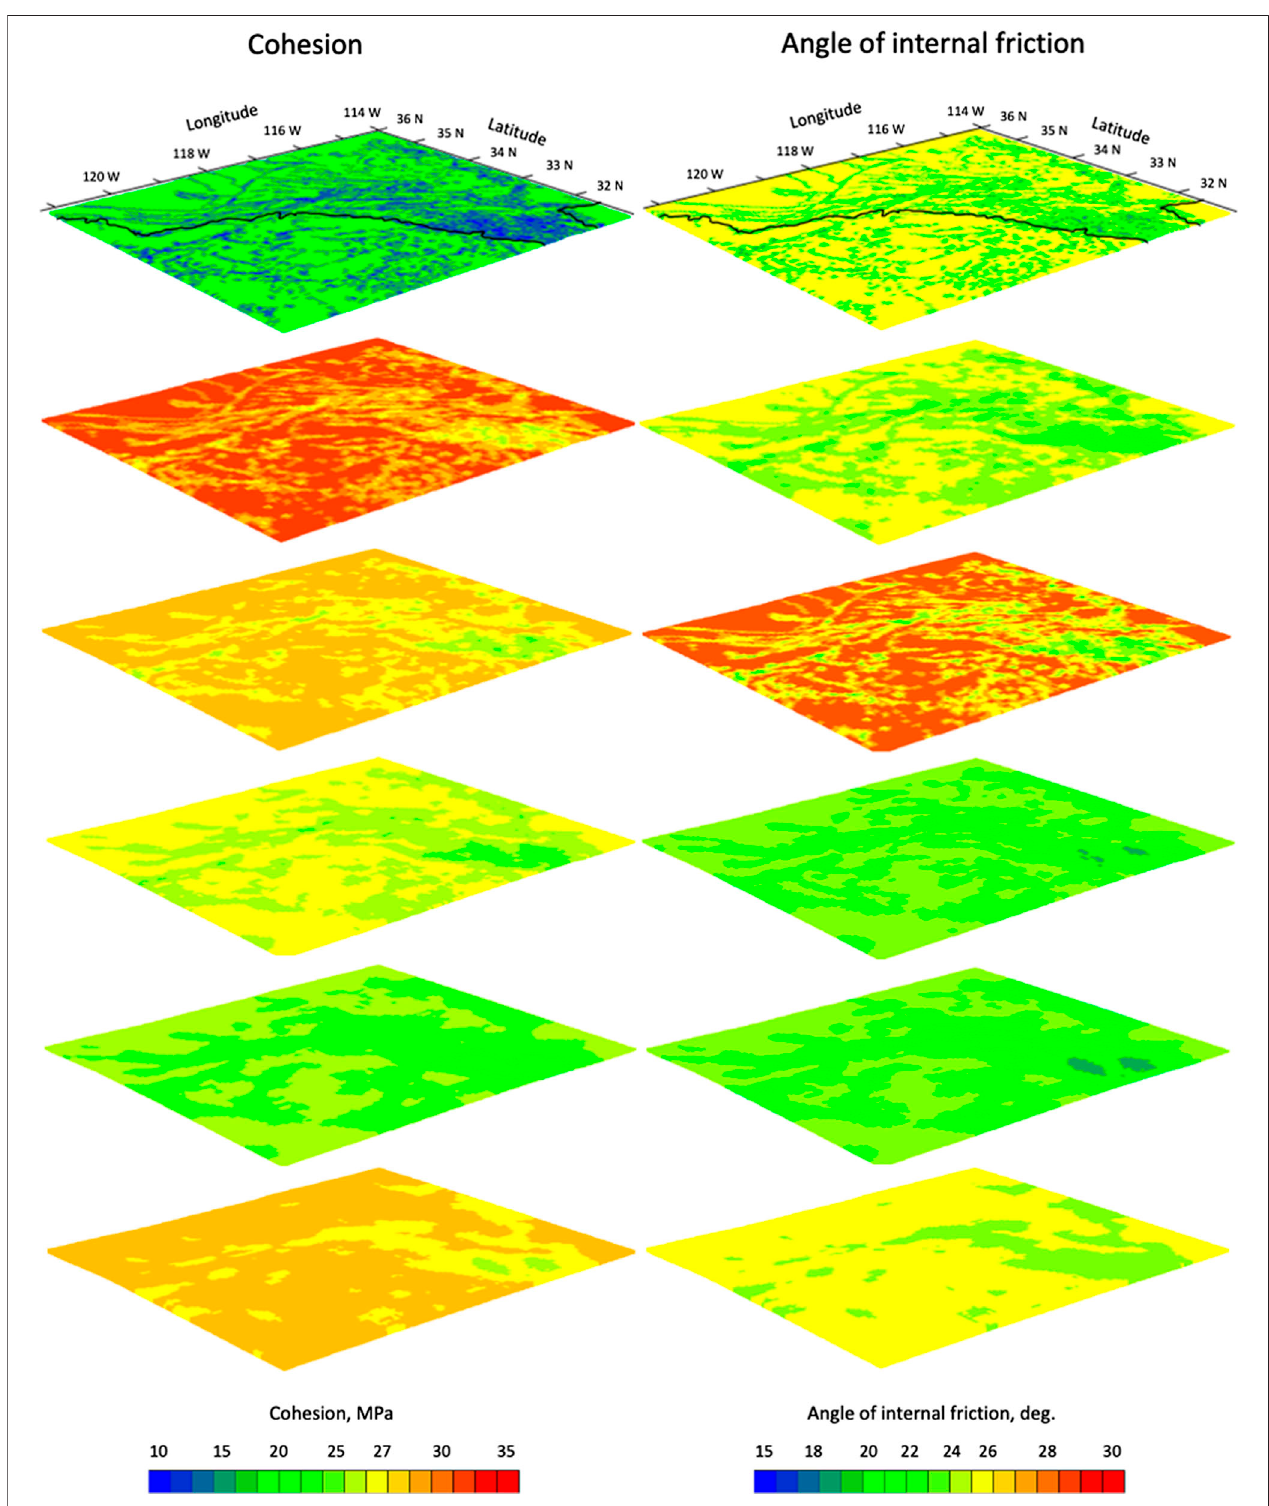
FIGURE 4 | Initial model properties for six crustal layers: cohesion (left column) and angle of internal friction (right column) distributions. Heterogeneous patterns re fl ect fault tectonics and reduced strength (assumed using the so-called damage function).